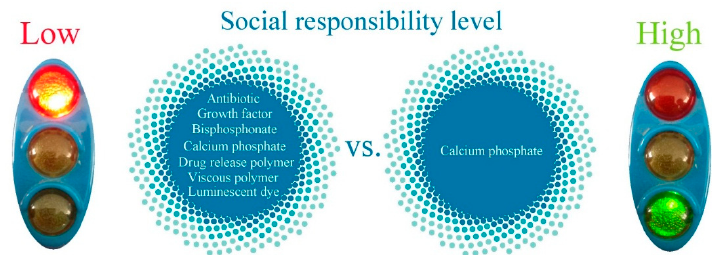
Figure 2. Two hypothetic bone graft formulations, one containing a multitude of functional components and the other one containing only calcium phosphate, albeit capable of possessing all the functional properties of the multicomponent formulation. Given their identical medical performance, the social responsibility levels of the two would differ: the first ones would be classified as low and the second ones as